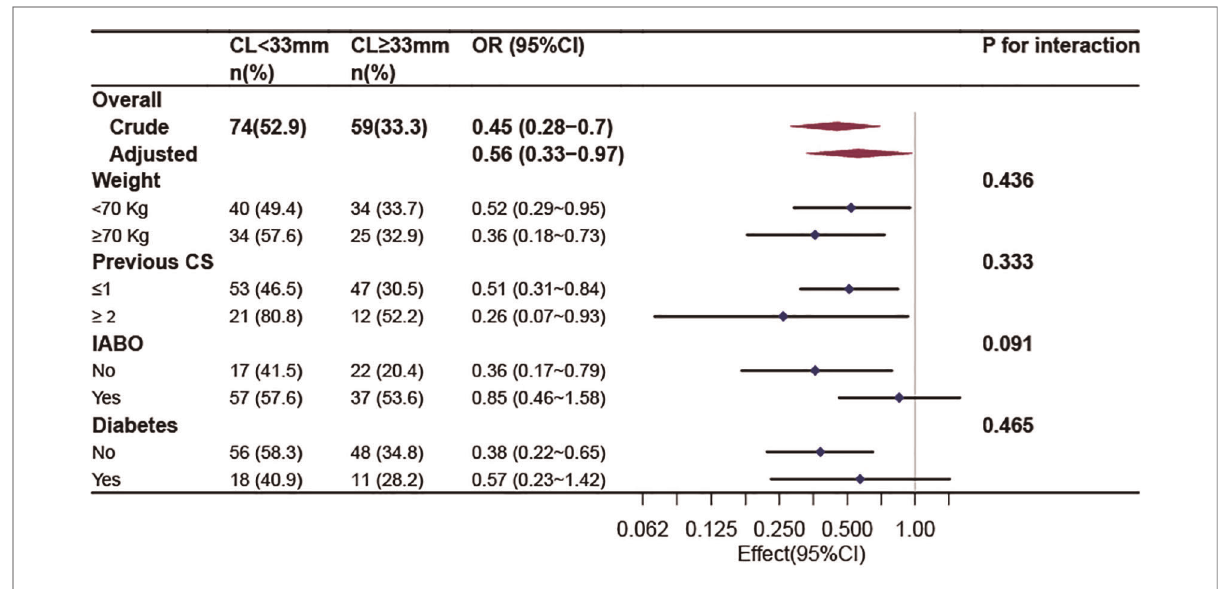
FIGURE 2 Strati fi ed analyses of the association between cervical length and massive bleeding according to baseline